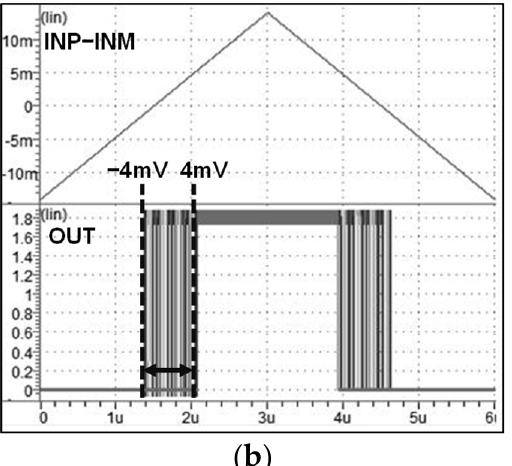
Figure 5. Comparator with offset voltage calibration: ( a ) circuit diagram; ( b ) simulation results.